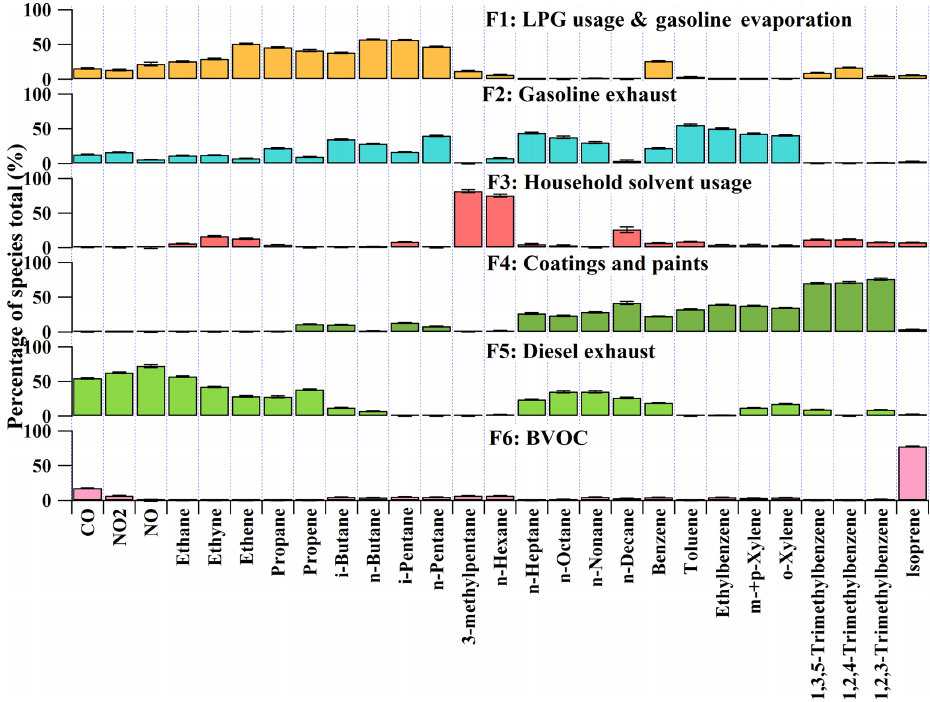
Figure 8. Average profiles of the O 3 precursors sources at TC in the three sampling campaigns. The uncertainties were estimated with the bootstrap method in